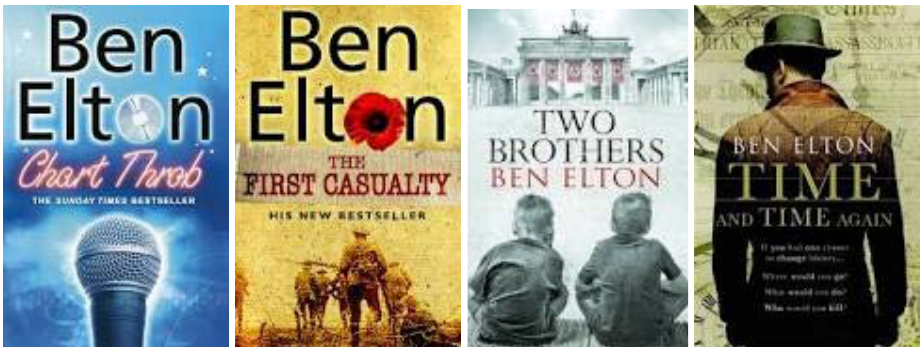
Figure 1. Comparison of ‘popular’ Elton with ‘literary’